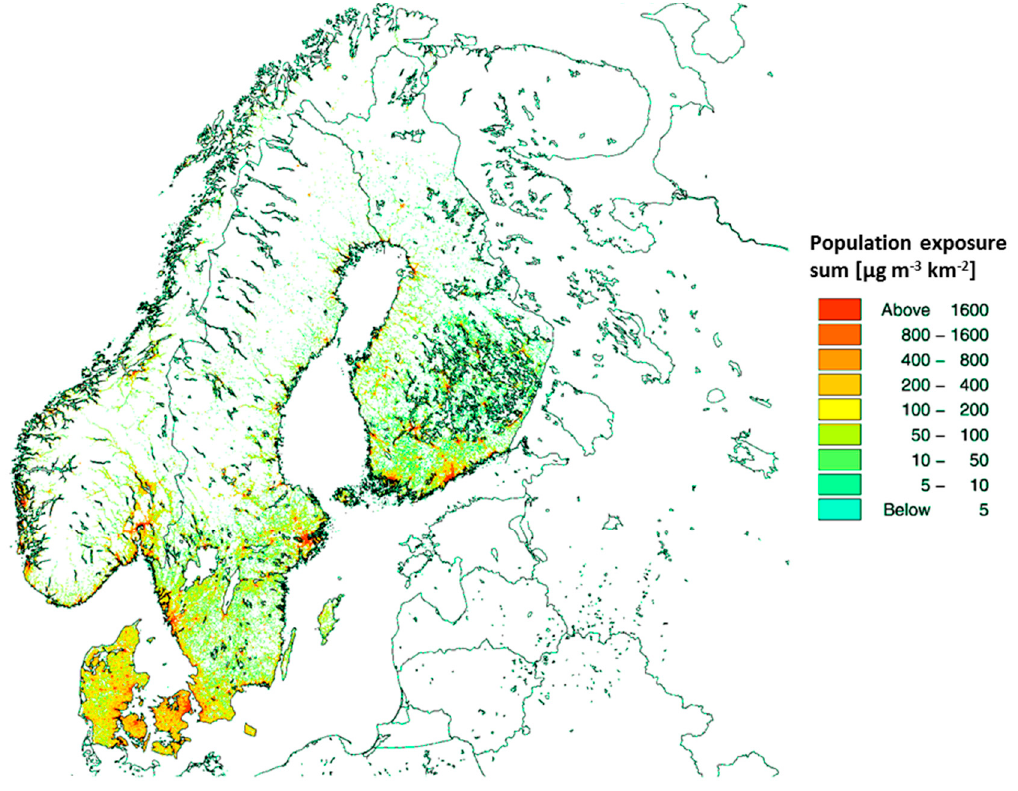
Figure 1. The gridded 1 km × 1 km annual exposure to PM 2.5 based on the simulated concentration from the Danish Eulerian Hemispheric Model (DEHM) / Urban Background Model (UBM) model multiplied with the population in each grid cell.